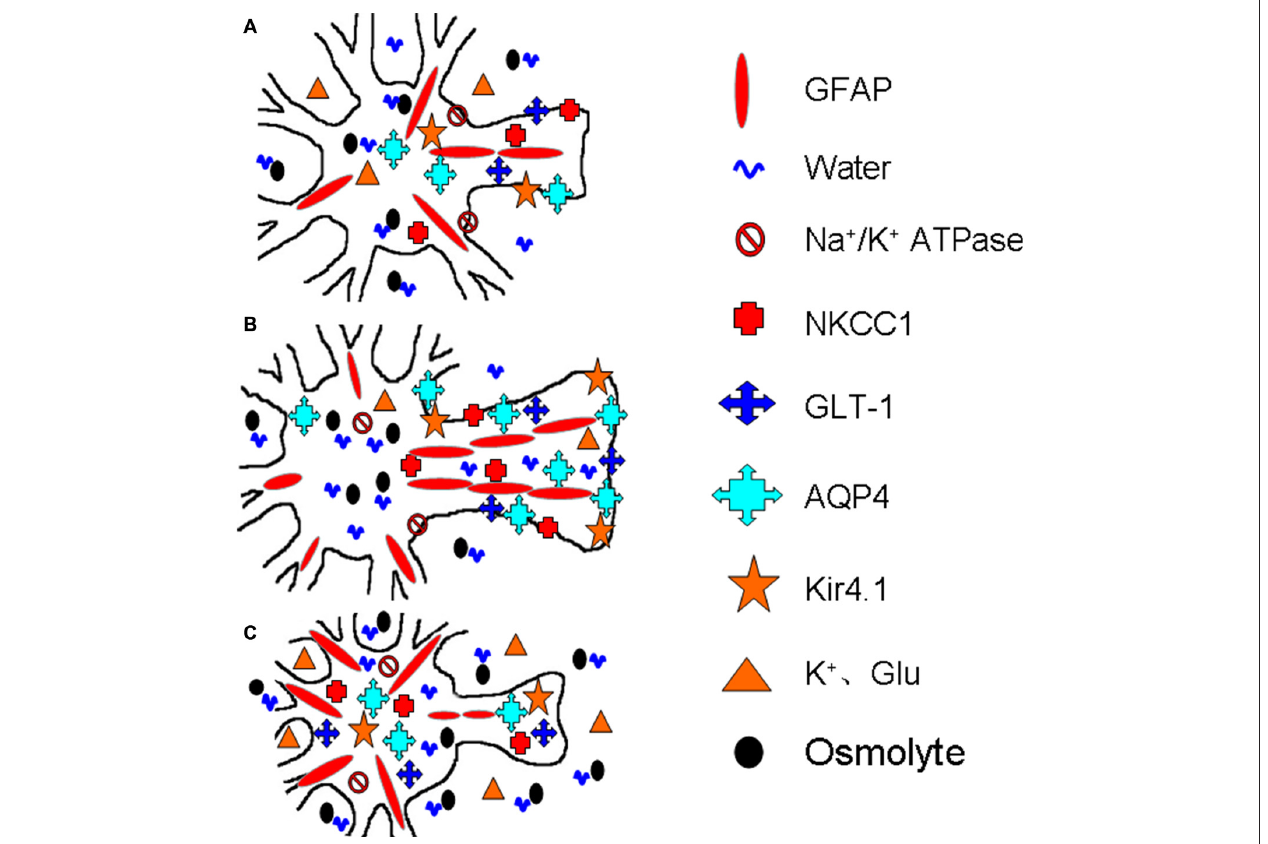
FIGURE 2 | Diagrammatic drawing of the astrocytic functional plasticity in ischemic stroke (A–C). The functional plasticity at different loci relative to the infarct core: normally irrigated tissues (A) , the penumbra (B) and the lesion core (C) , respectively. The abbreviations are, AQP4, Aquaporin-4; GFAP, glial fibrillary acidic protein; GLT-1, glutamate transporter-1; Kir4.1, inward rectifier K + channel 4.1; NKCC1, Na + , K + , 2Cl − and water co-transporter. Others refer to Figure 1